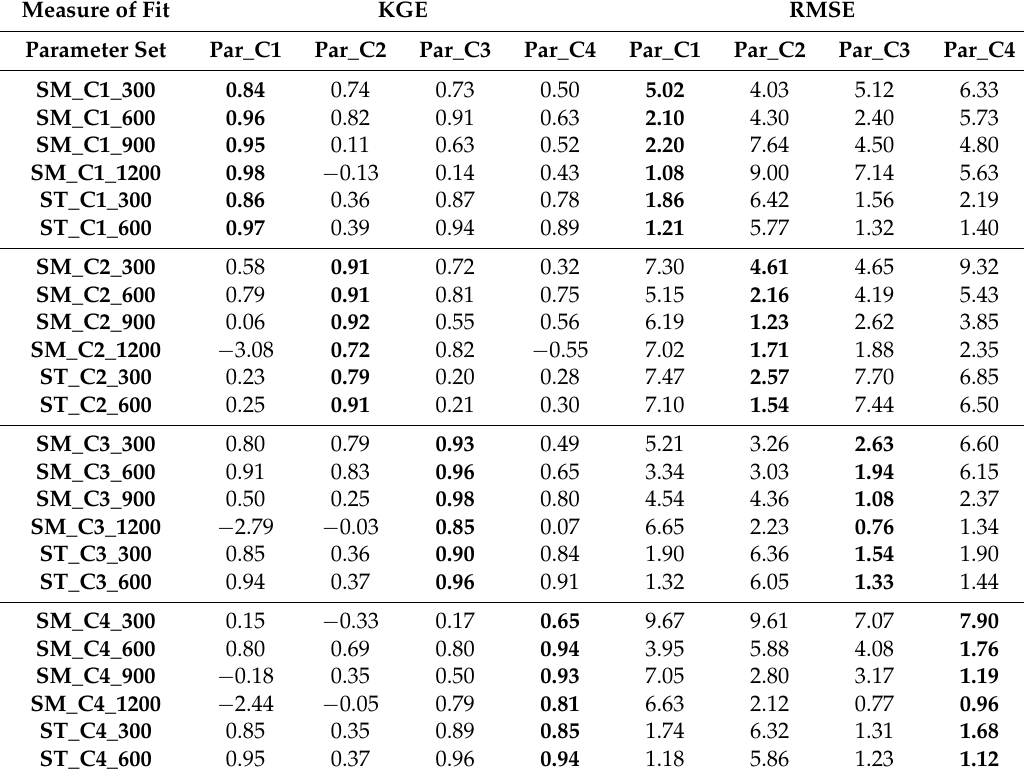
Table 2. Kling-Gupta Efficiency (KGE) coefficients and root mean squared error (RMSE) values quantify the model goodness of fit. The coefficients are reported for each optimal parameter set (Par_C1, Par_C2, Par_C3, and Par_C4) calibrated in each location (C1, C2, C3, and C4, respectively) and for each